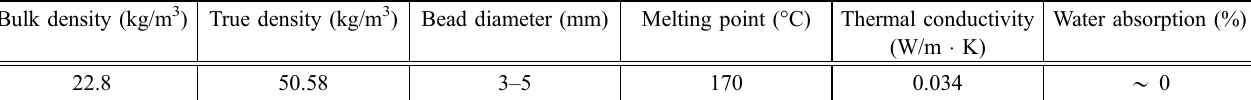
Table 2 Material properties of EPS